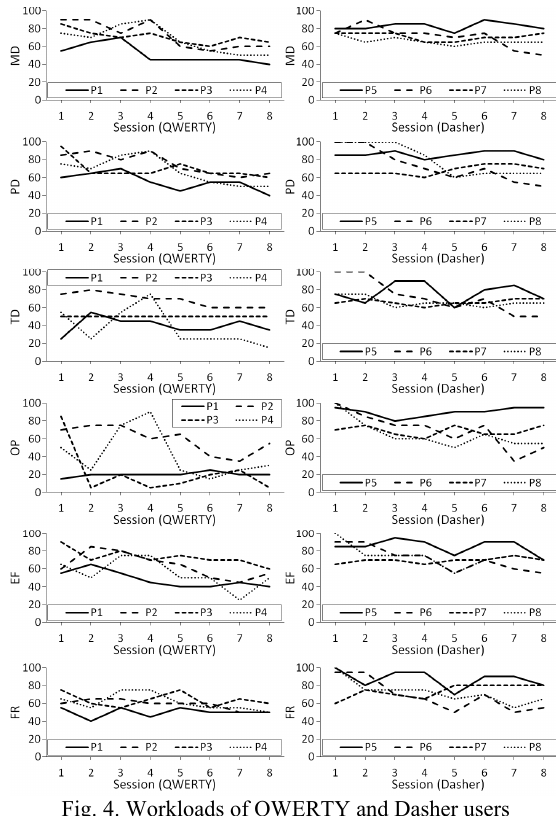
Fig. 4. Workloads of QWERTY and Dasher